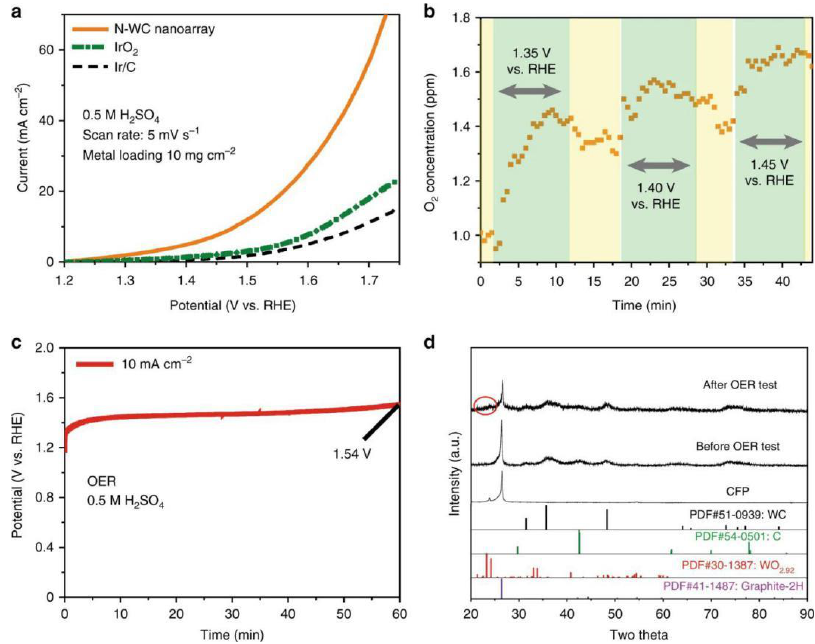
Figure 5. ( a ) OER polarization curves tested in 0.5 M H 2 SO 4 of an N-WC nanoarray, IrO 2 , and 20 wt % Ir/C. ( b ) O 2 concentration in 0.5 M H 2 SO 4 when different potentials are intermittently applied to